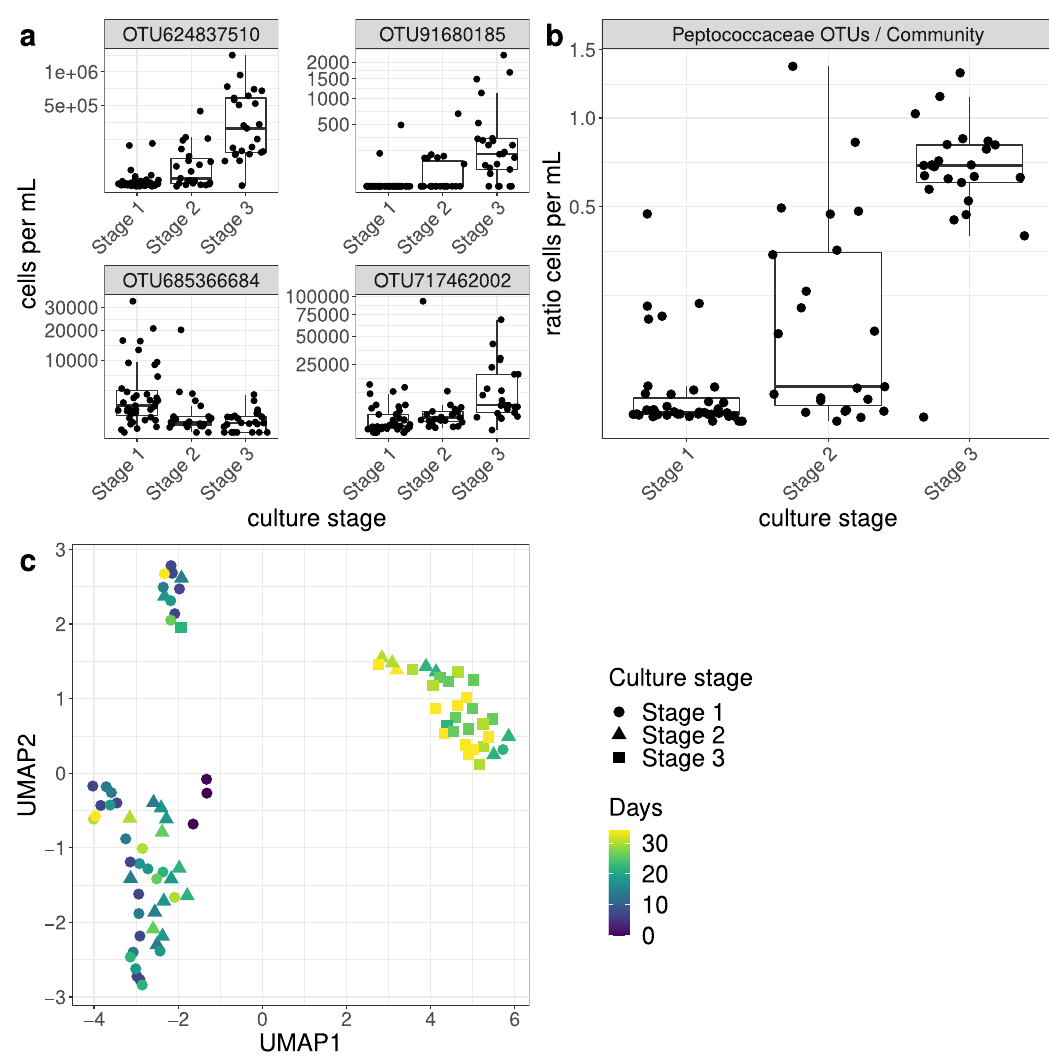
Fig. 4 Peptococcaceae drive changes of the community composition and the progression of benzene degradation. a Relationship between culture stage and cell abundance of 4 selected OTUs (by random forest variable importance and PERMANOVA analysis). b Relationship between culture stage and ratio of cell abundance between the Peptococcaceae OTUs with the rest of the community. The abundance axis has a square-root scale, and points are jittered relative to the culture stage axis. Note that OTU685366684 was correlated with stage 1 and identi fi ed as Pseudomonas aeruginosa species, a taxonomy not strongly represented in the bioreactor. c The succession in time of the community structure in relationship with the culture stage is shown, with the usage of UMAP and Bray-Curtis dissimilarity on relative cell abundance matrix. Note that the most diverse community structures are observed in the bottom left cluster of the panel, which includes points that belong to stages 1 and 2 throughout all time points of succession (day 0 to 34). A smaller, denser cluster in the top exhibit a similar trend. The cluster in right is composed of cultures from stage 2 and 3 (mid and late phase of the succession). Based on PERMANOVA, the community structures were found signi fi cantly different based on the three culture stages (pseudo- R 2 : 0.268 with p -value: